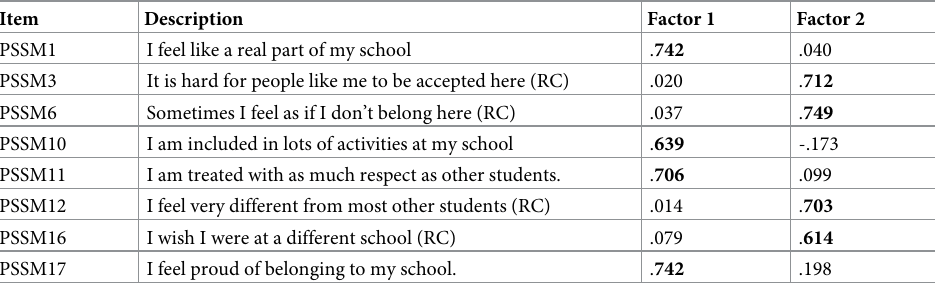
Table 3. Factor structure matrix of the two-factor